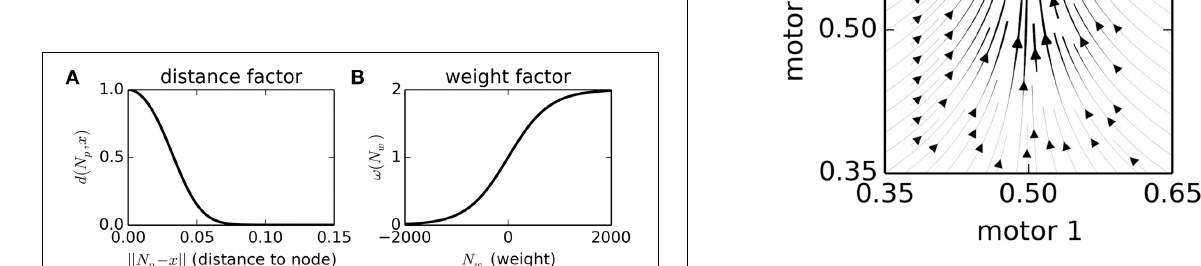
FIGURE 1 | Non-linear functions used to calculate the node-density of a SM-state, and to scale the influence of nodes by their proximity to the current SM-state (Plot A) and by their weight (Plot B). See main text for details.